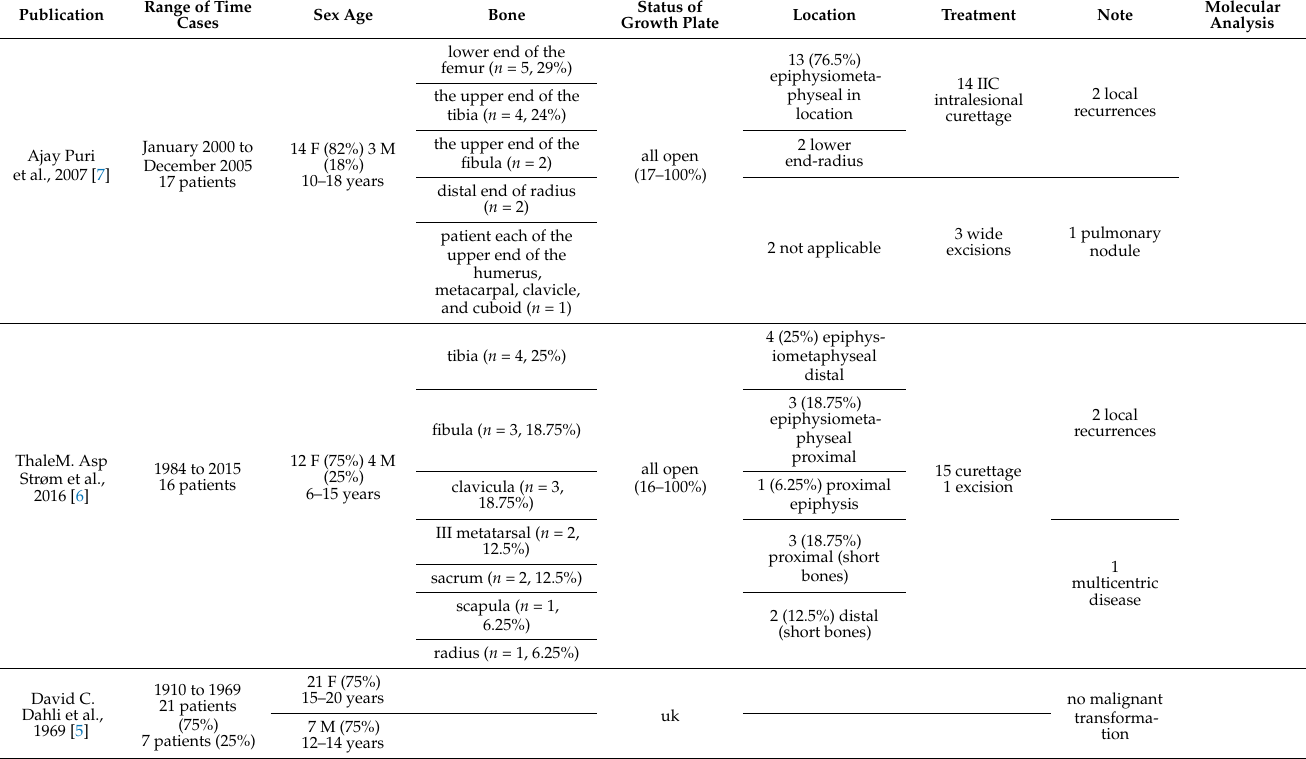
Table 2. Summary of the principal case series review of English literature of GCTB in pediatric